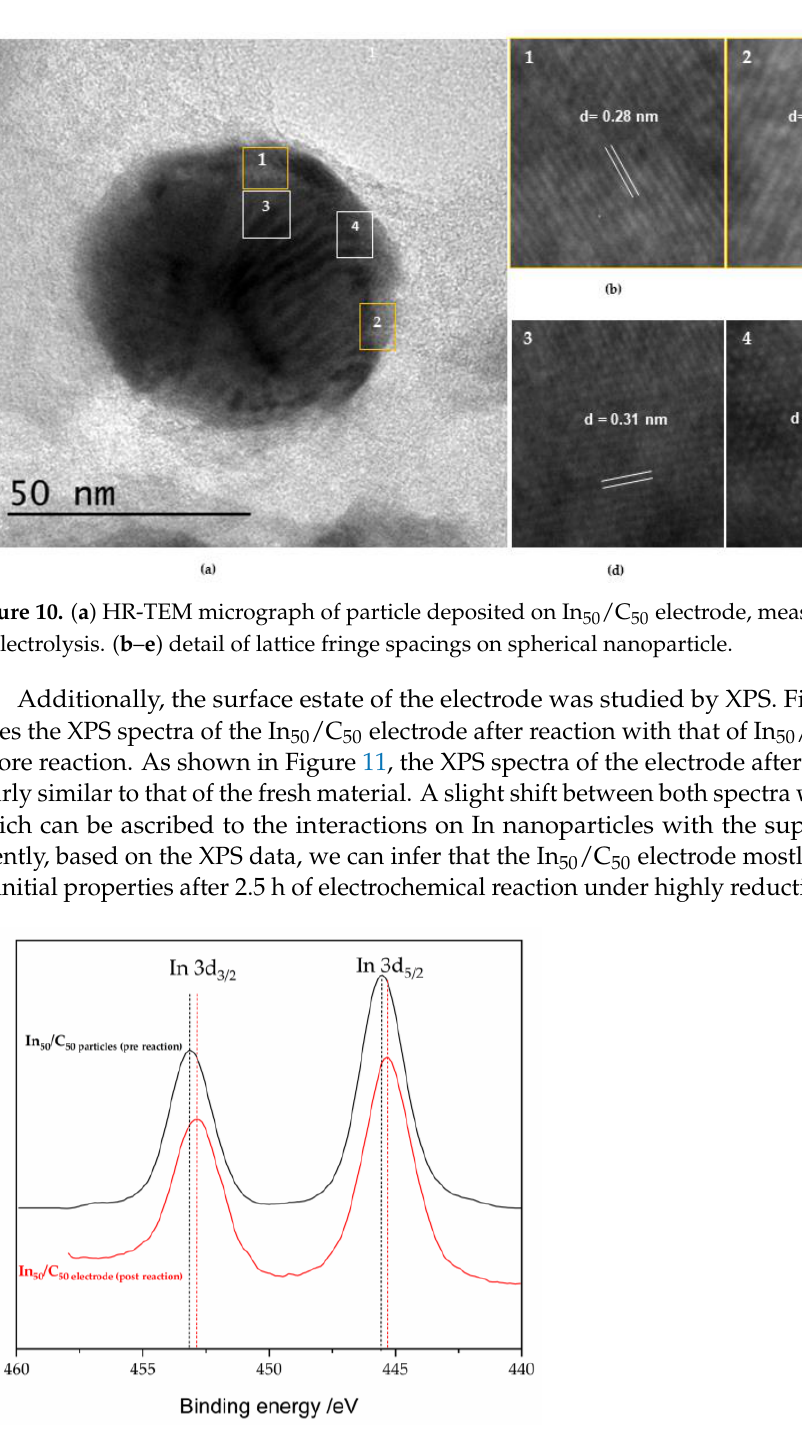
Figure 11. XPS spectra of In 3d for In 50 /C 50 NPs pre reaction and electrode post reaction.